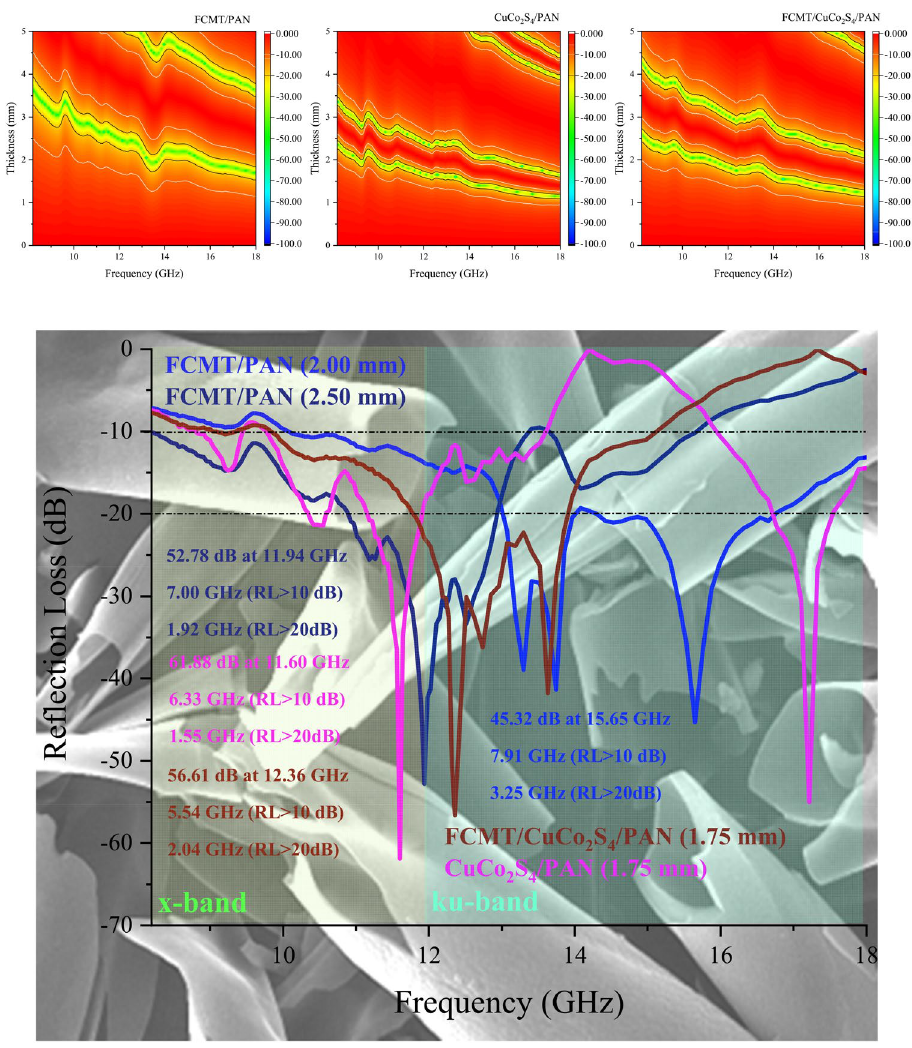
Figure 8. Microwave absorption and efficient bandwidth of the samples at x and ku-band frequencies.